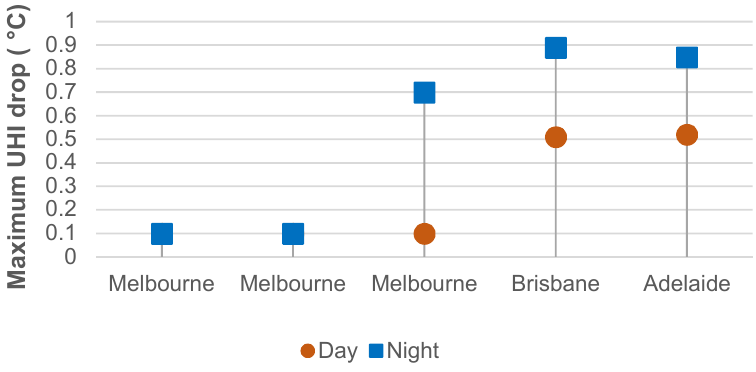
Figure 3. Performance of urban greenery (day vs. night).